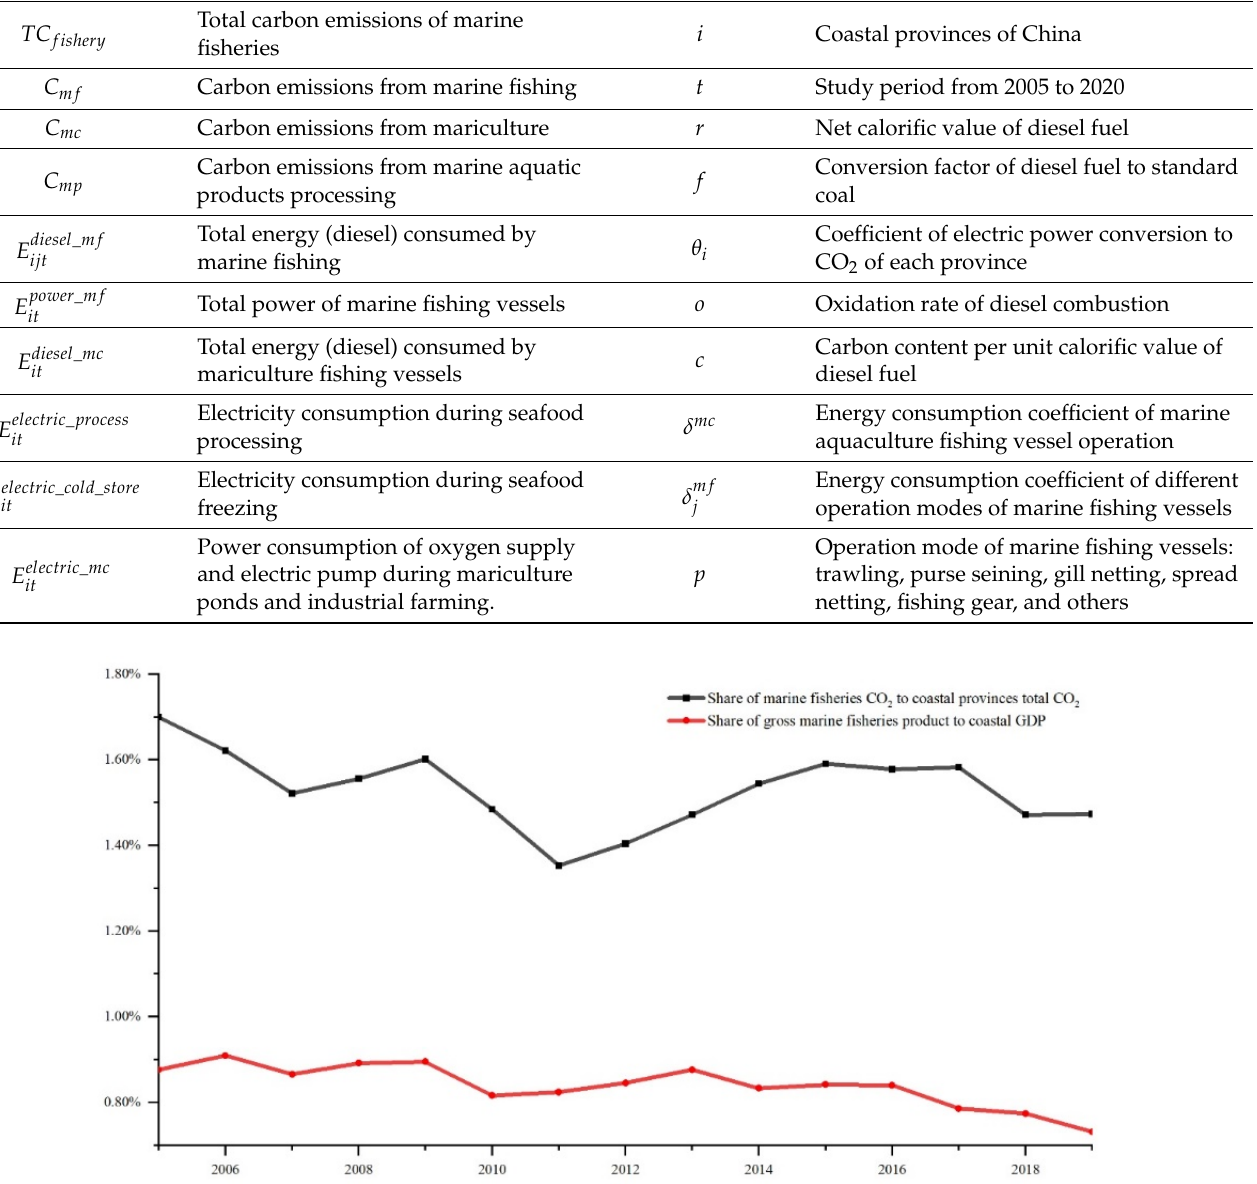
Table 2. Explanation of variables.